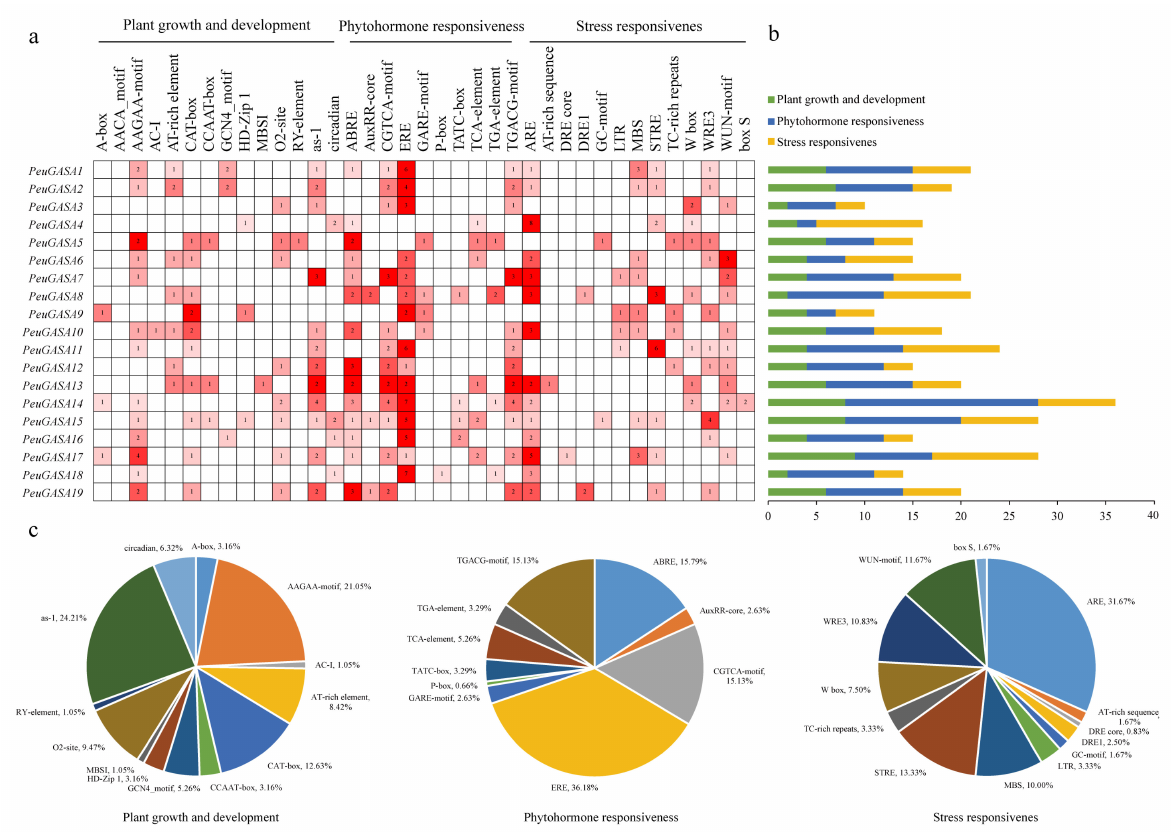
Figure 9. The cis -acting elements of PeuGASA genes. ( a ) Numbers and gradient red colors indicate the number of cis -acting elements; ( b ) Color-coded histograms indicate the number of cis -acting elements of genes in each category; ( c ) Pie charts show the proportion of different cis -acting elements in each